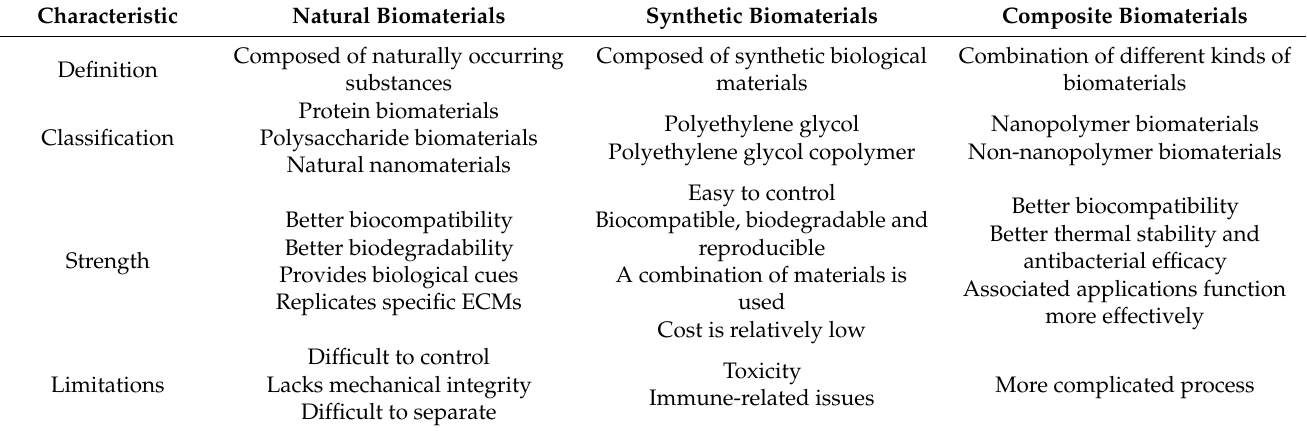
Table 3. Differences between the three types of biological materials